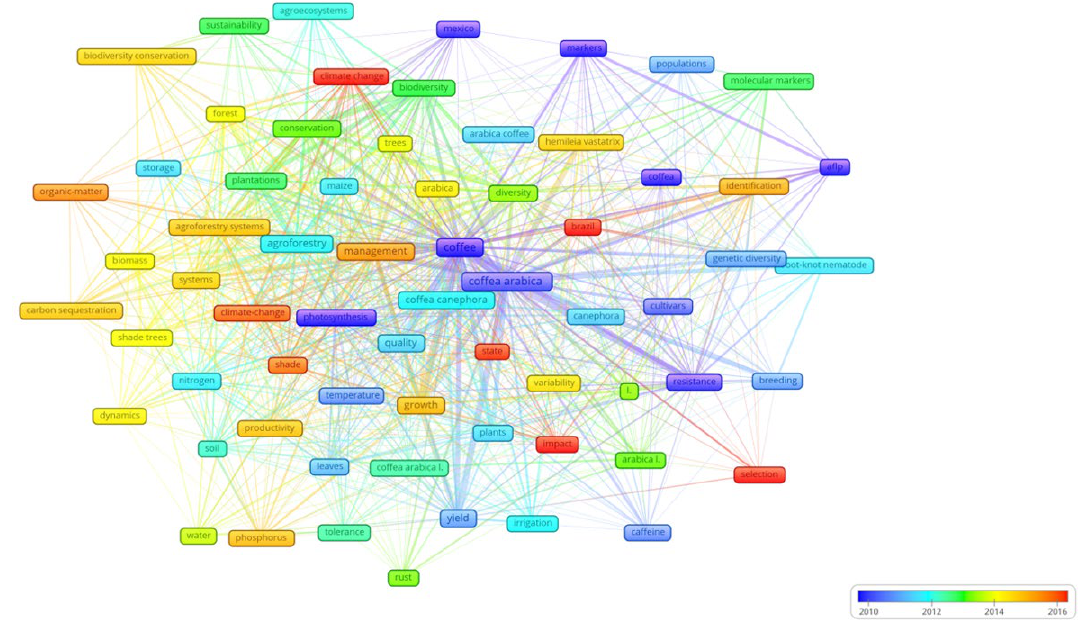
Figure 7. Coffee agronomy research keywords co-occurrence network, temporary visualization.